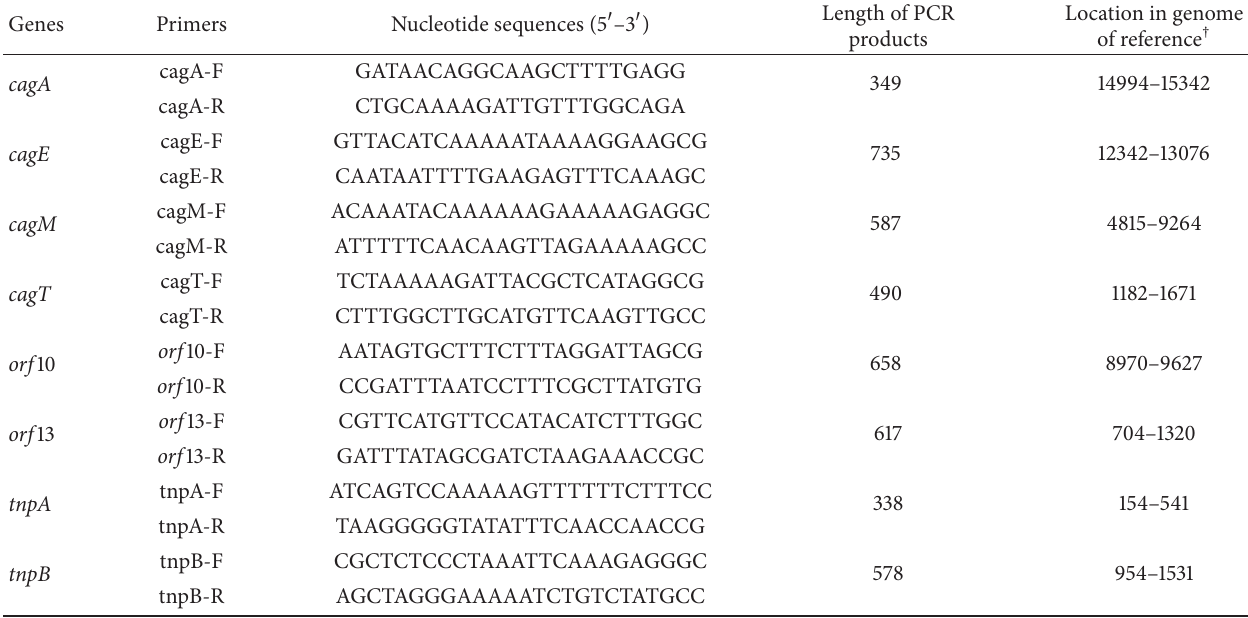
Table 1: PCR primers used to detect CagA, CagE, CagM , CagT, orf10, orf13, TnpA, and TnpB in H. pylori isolates.